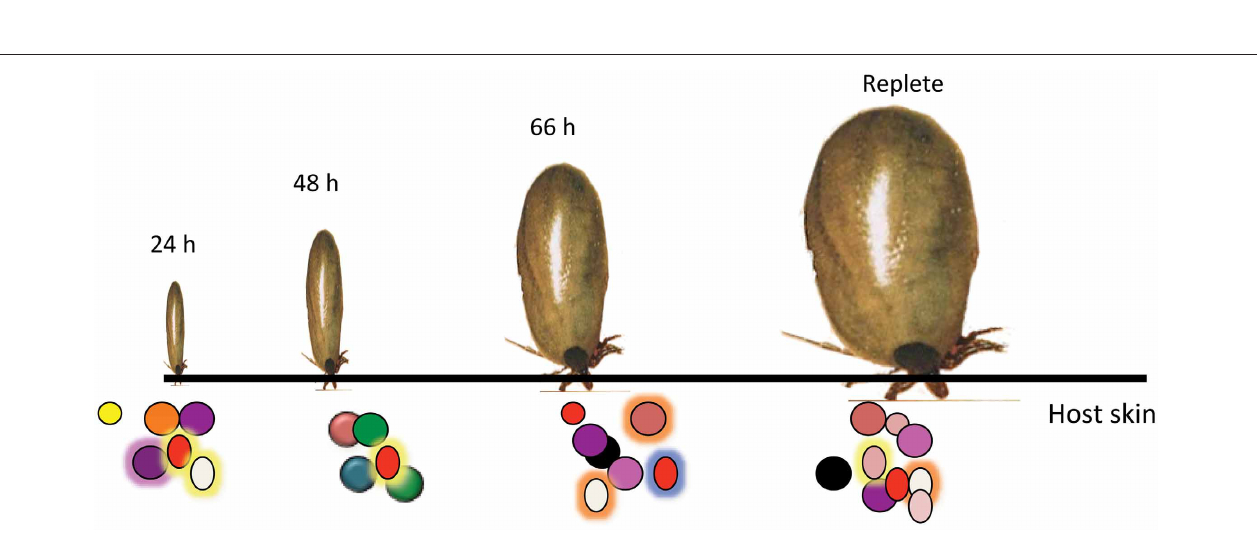
FIGURE 3 | Temporally changing composition of tick saliva spit into the host skin. Schematic representation of the dynamic tick saliva. Ixodes scapularis engorge on vertebrate host skin for 3–7 days spitting